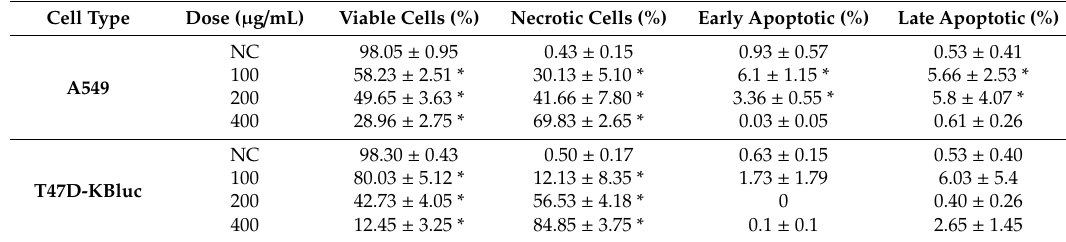
Table 7. The percentage of viable, necrotic, early apoptotic and late apoptotic cells (A549, T47D-KBluc) after a 24 h exposure to WSE, measured using flow